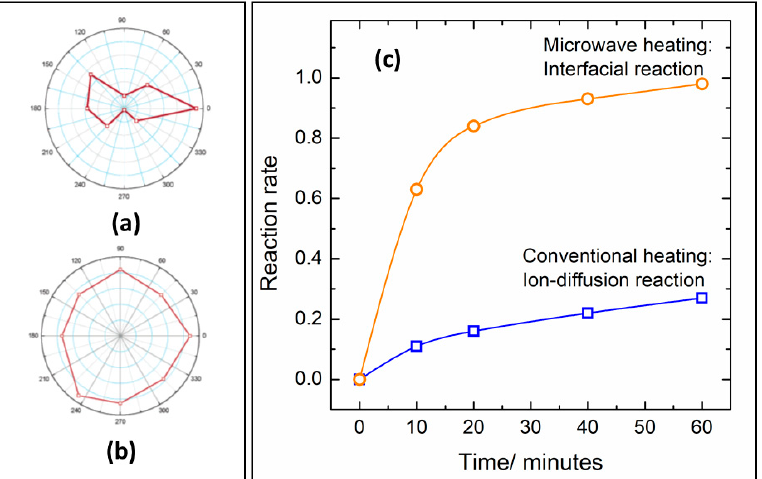
Figure 4. Ionic diffusion in a ceramic heated by polarized microwave irradiation ( a ) and conventional heating ( b ). Adapted from reference [70]. Reaction rates of NiFe 2 O 4 synthesis under microwave heating (orange) and resistive heating (blue) at 850 °C ( c ). Adapted from ref. [71]. Copyright © 2005, American Chemical Society.